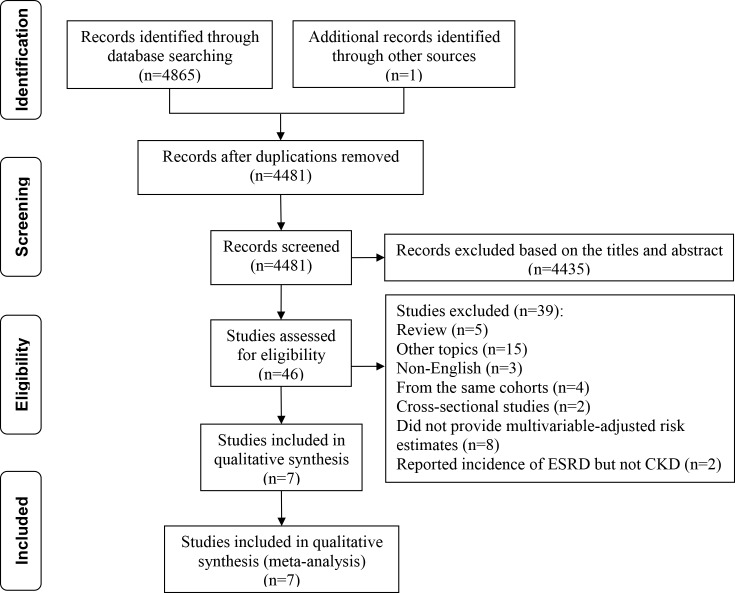
Flow chart of study selection.